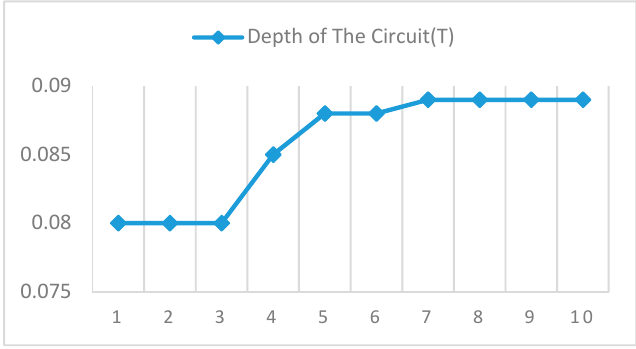
Figure 11. Average execution time for the user.